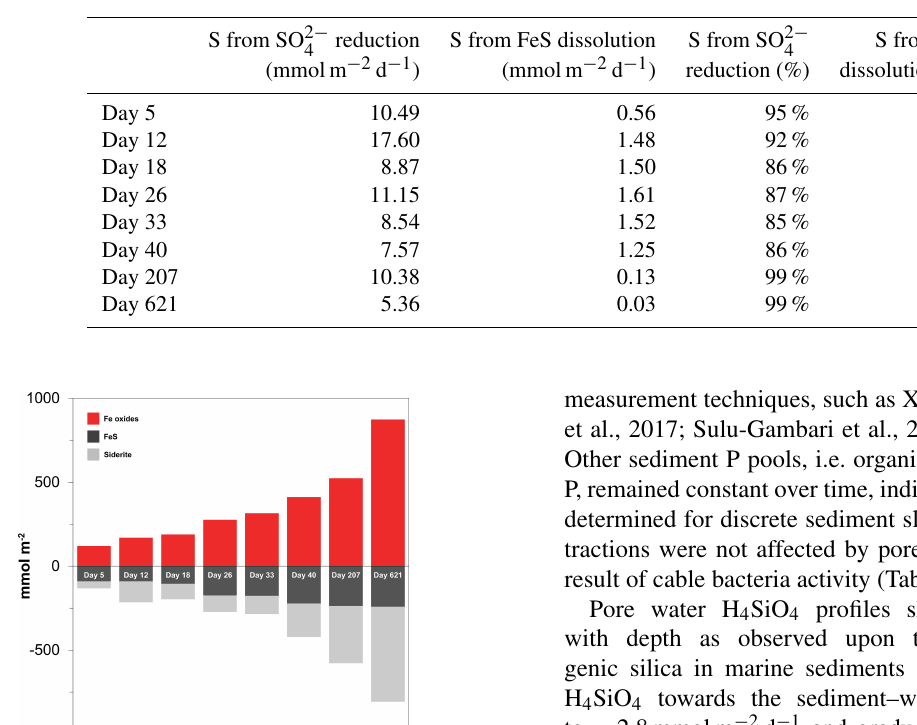
Table 4. Sources of (cid:80) H 2 S calculated from the reduction in SO 2 − and the dissolution of FeS. The numbers are presented either as 4 mmolm − 2 d − 1 or as the relative percentage of the (cid:80) H 2 S production. The amount of S from the dissolution of FeS was estimated from the upward diffusive flux of Fe 2 + (Fig. 6c) and the relative fraction of FeS (FeS / FeS + siderite), based on the mass balance calculations (Table 3).